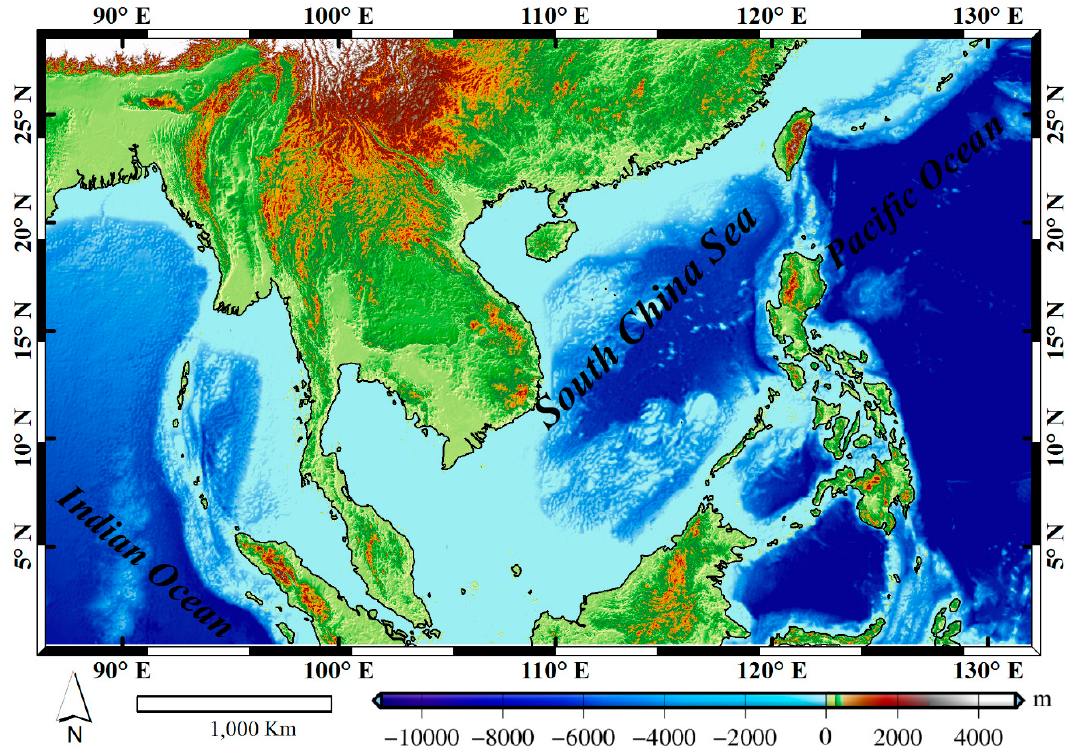
Figure 1. Study area and the center latitude and longitude of the area used in the present study.